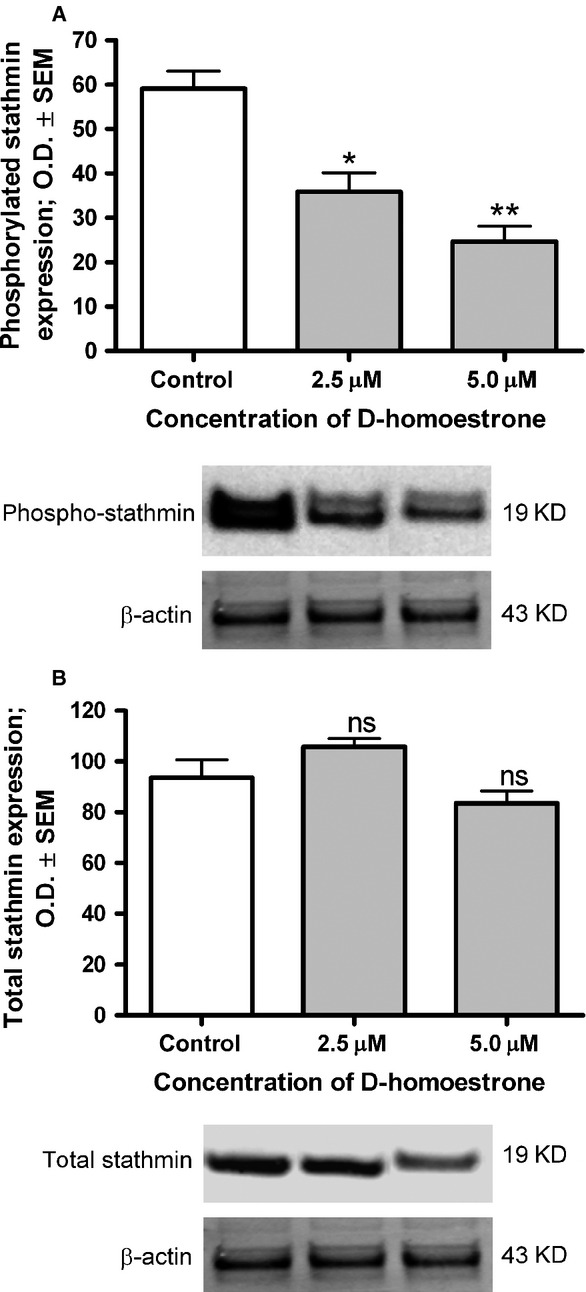
Effects of 2.5 and 5.0 μM d-homoestrone on the expression of phosphorylated (A) and total (B) stathmin protein in HeLa cells after incubation for 48 hrs, determined by western blot analysis. Results are mean values ± SEM of the data from two separate measurements, n = 6. ns indicates P > 0.05, * indicates P < 0.05 and ** indicates P < 0.01 as compared with the untreated control cells. The β-actin probe was used as internal control. Panels below are representative membrane pictures.